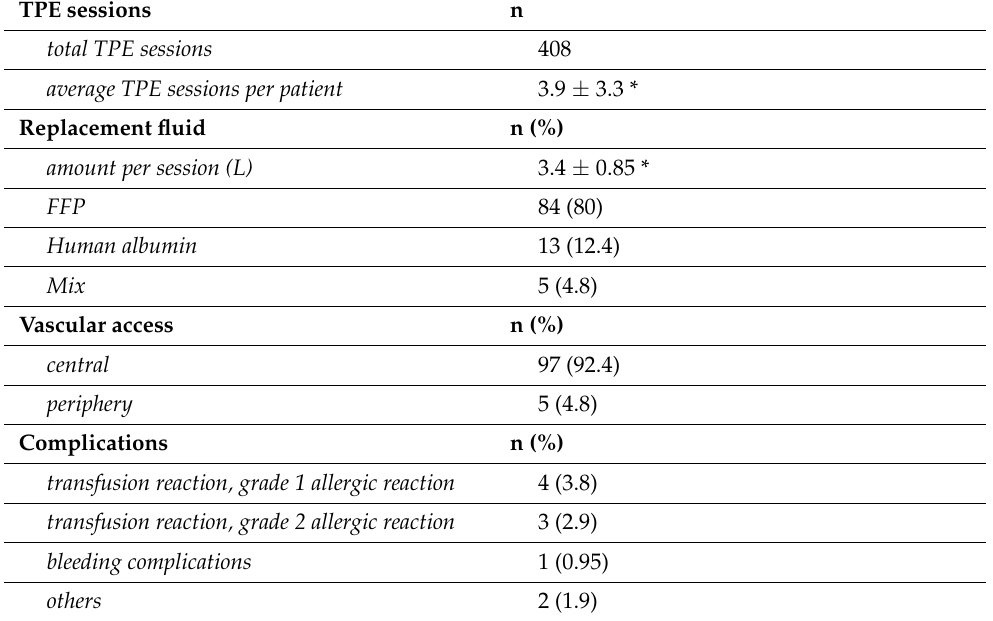
Table 5. TPE-specific parameters . Data are shown as patients per category and percentage of the total population. * Data expressed as mean ± SD. Abbreviations: FFP—fresh frozen plasma, TPE—therapeutic plasma exchange. SD—standard